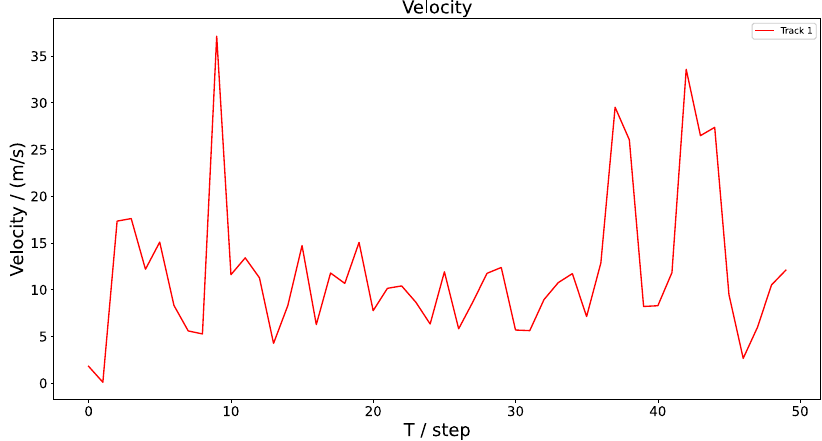
Figure 16. Tracking error between the prediction and actual track (REMTT).